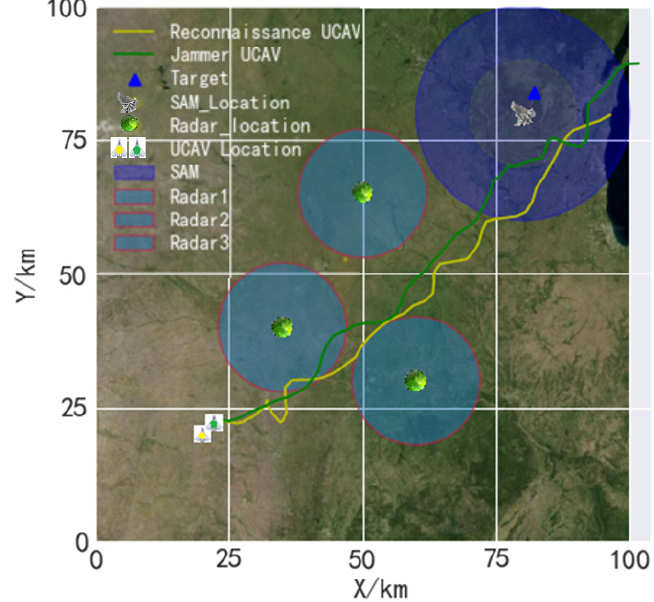
Figure 7. Mission planning of the dual-UAV cooperative reconnaissance high-value target.